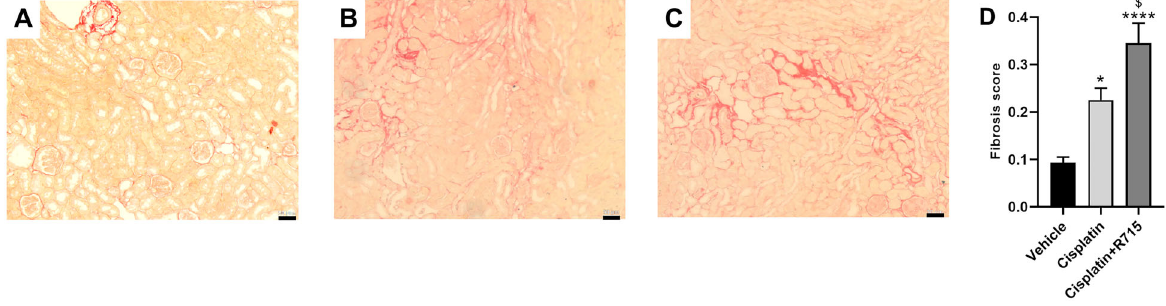
Figure 7. Kinin B1 receptor antagonism exacerbates cisplatin-induced tubulointerstitial fi brosis. Sirius red stained representative images of the vehicle ( A ), cisplatin ( B ), and cisplatin + R715 ( C ) groups. Scale bars, 50 m m. Fibrosis score was determined by Sirius red positive areas ( D ). Data are reported as means ± SE (n=6 per group). *P o 0.05, ****P o 0.0001 compared to the control group; $ P o 0.05 compared to the cisplatin group (one-way ANOVA followed by post hoc Tukey ’ s